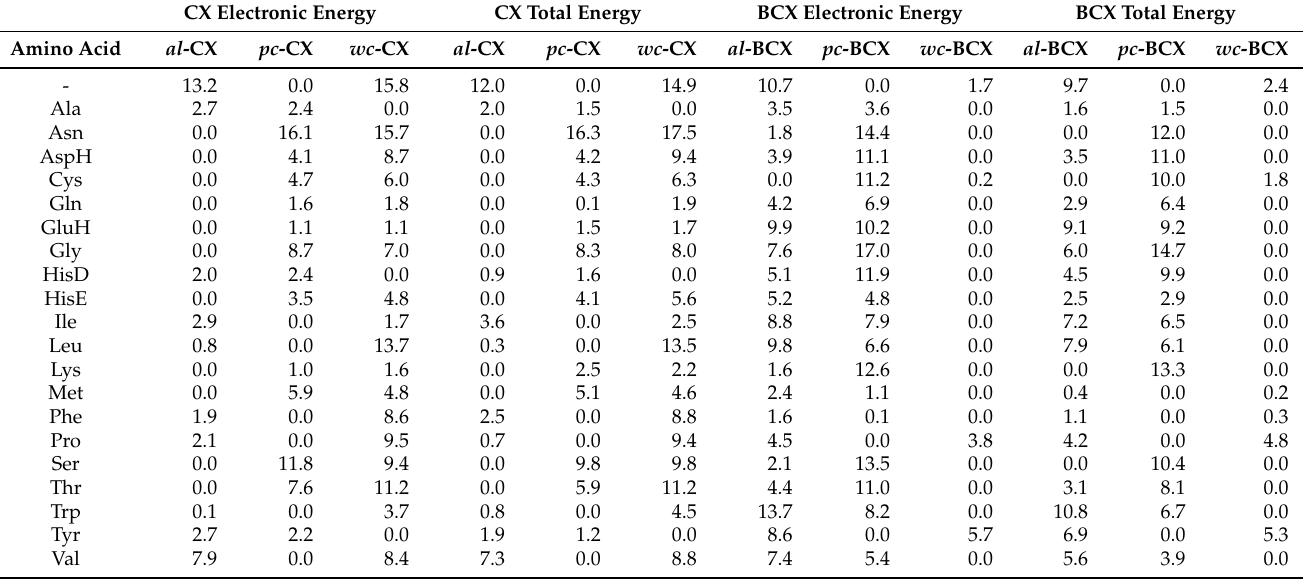
Table 1. The relative electronic and total energy of both empty calixarenes in three considered conformations, and complexes of these conformations with amino acids with respect to the lowest conformation energy. Energies in